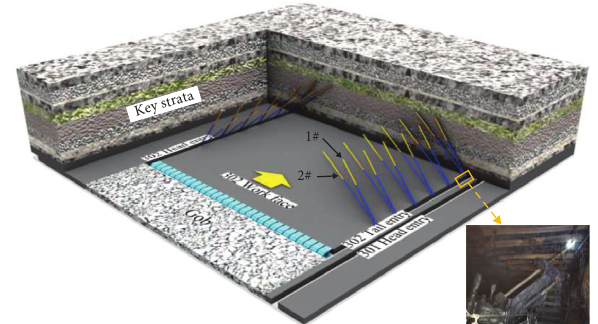
Figure 3: Schematic diagram of the operation process of roof deep- hole